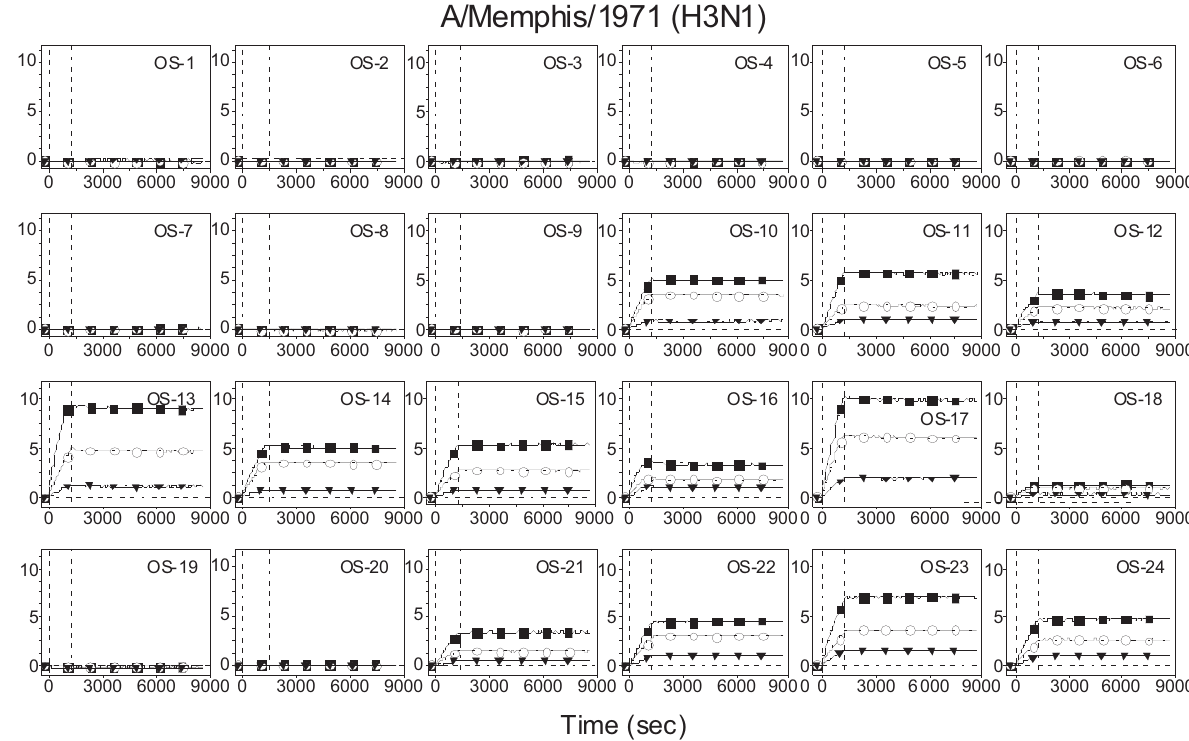
Figure 1. Association-dissociation (binding) curves of A/Mem71 to 24 biotinylated oligosaccharides immobilized in microarray format on streptavidin functionalized glass slide. The y-axis displays the ellipsometry signal in arbitrary unit and is proportional to the surface mass density of the capture viruses. An ellipsometry signal of 20 corresponds to a fully covered monolayer of influenza A viruses. The viral concentrations are 2.5 × 10 4 HAU/mL (solid squares), 1.25 × 10 4 HAU/mL (open circles), and 0.42 × 10 4 HAU/mL (solid triangles). The virus solutions were mixed with 0.1 mM Zanamivir. Vertical lines mark starts of association and dissociation phases of the binding events, respectively. The solid lines through the curves are global fits to a 1-to-1 Langmuir reaction model to yield apparent equilibrium dissociation